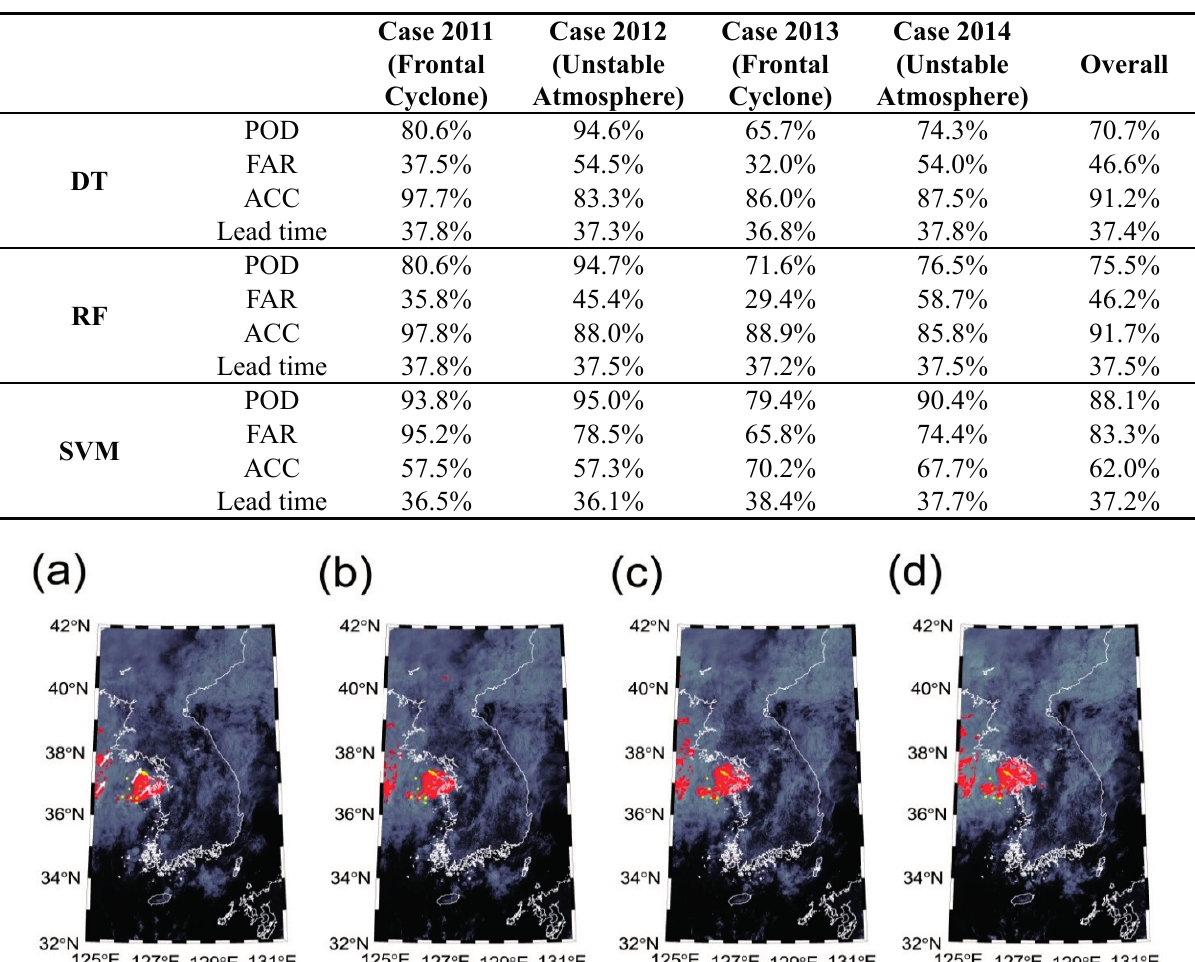
Table 8. Validation statistics and averaged lead times from the DT, RF, and SVM models for the four case days.